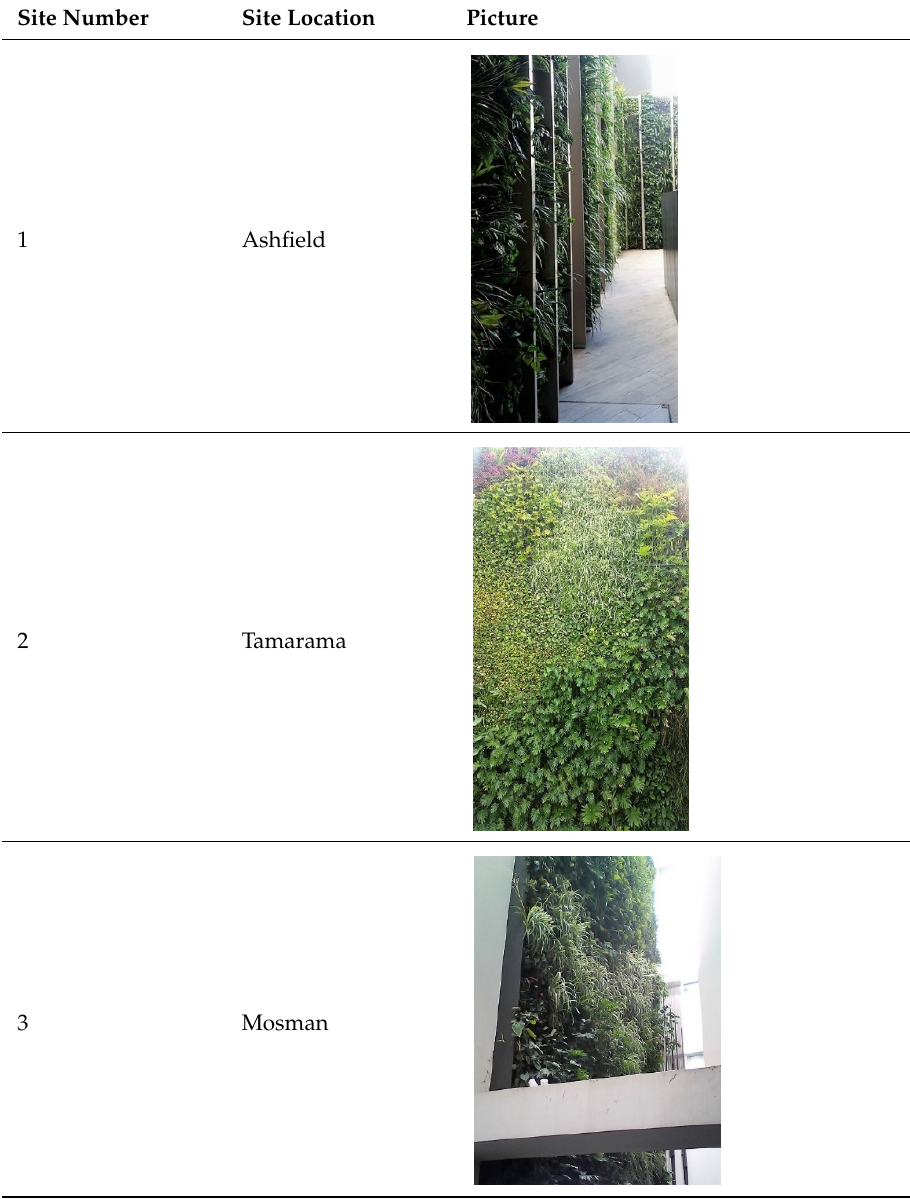
Table A1. Test sites with a visual aid.